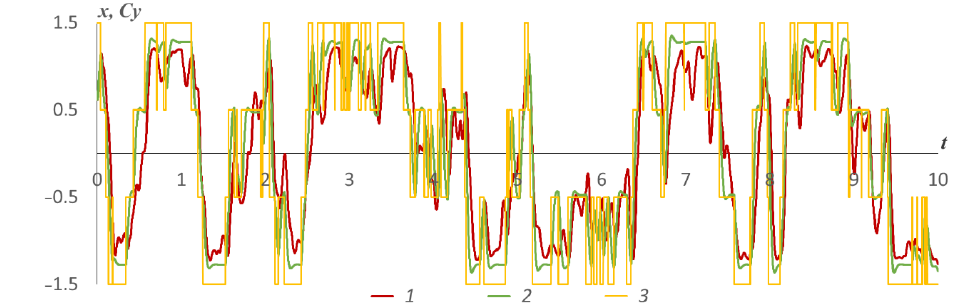
Figure 11. The results with the CTMC dimensionality 4 and transition intensities 10: 1—the system state, controlled by ˘ u δ